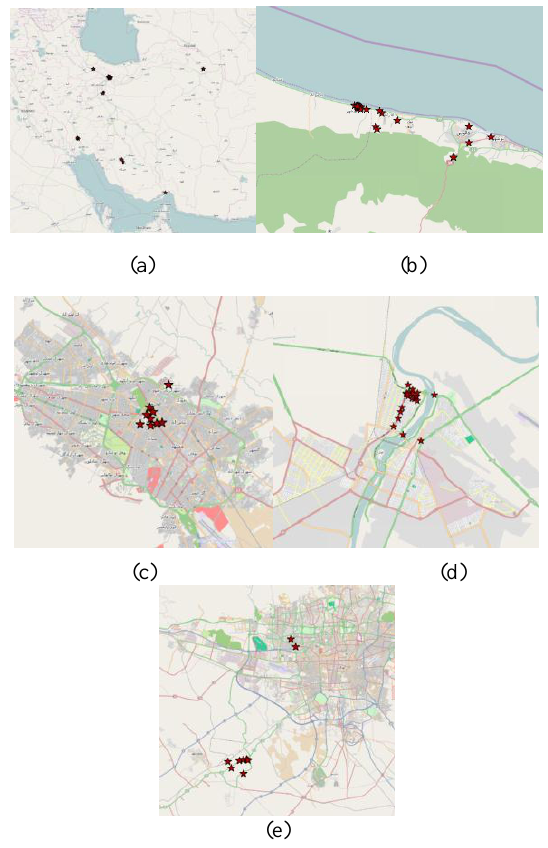
Figure 3. Propagation of POIs for Player rank 1 (a), rank 2(b), rank 3 (c), rank 4 (d), rank 5